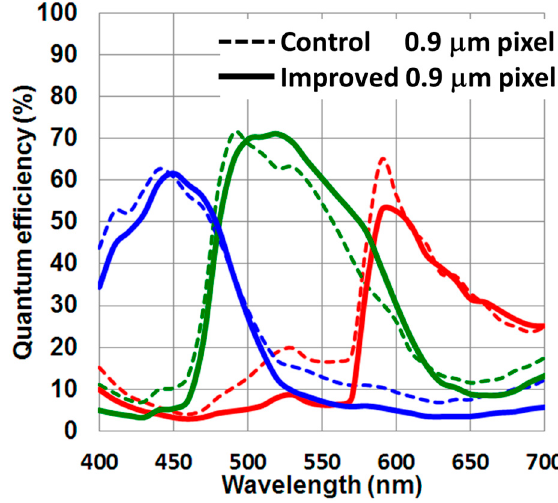
Figure 15. Measured quantum efficiency spectra of 0.9 µm pixels. Dashed line is the control 0.9 µm pixel, and the solid line is the improved 0.9 µm pixel.